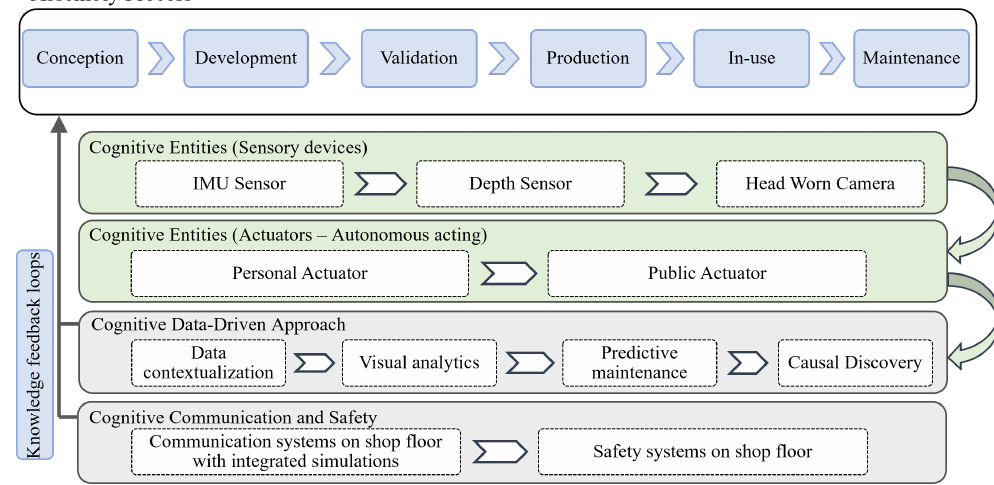
Figure 1. Specifics of a cognitive assembly line. A holistic top-down approach of the paper can be seen, where various cognitive areas are explained in further